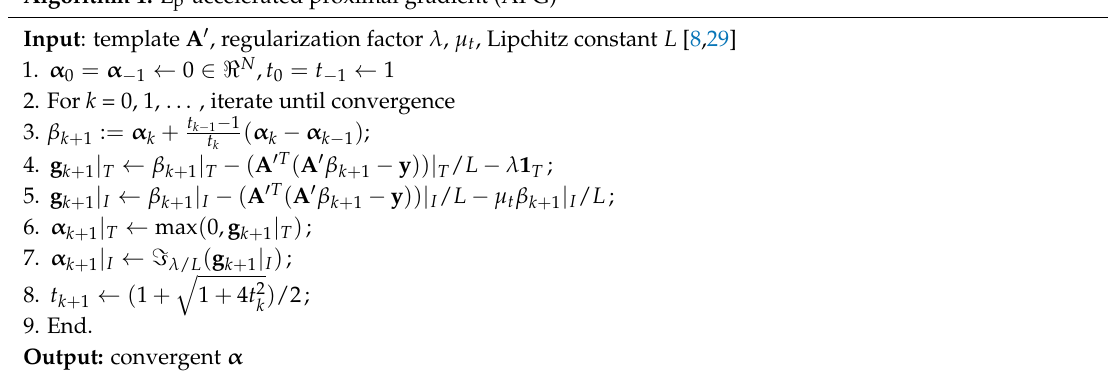
Algorithm 1. L p -accelerated proximal gradient (APG)